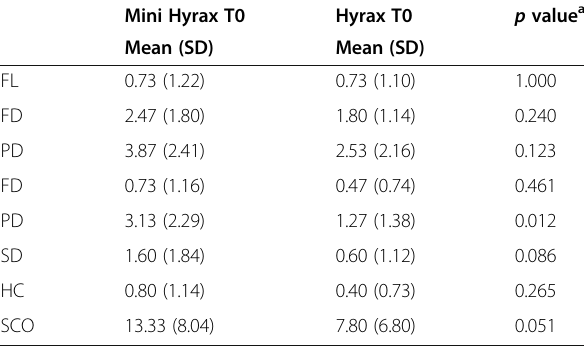
Table 3 Comparison of OHIP scores at T0 between Mini Hyrax wearers and Hyrax